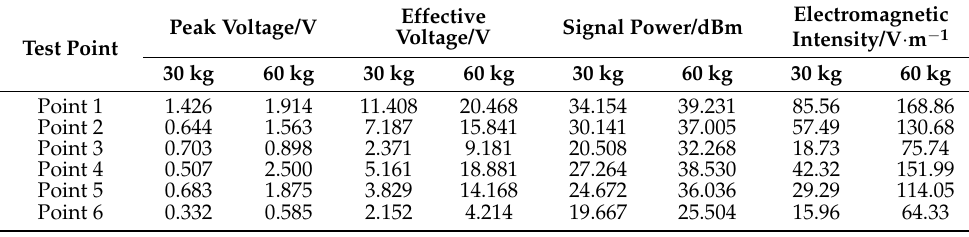
Table 1. Experimental data of electromagnetic radiation of TNT